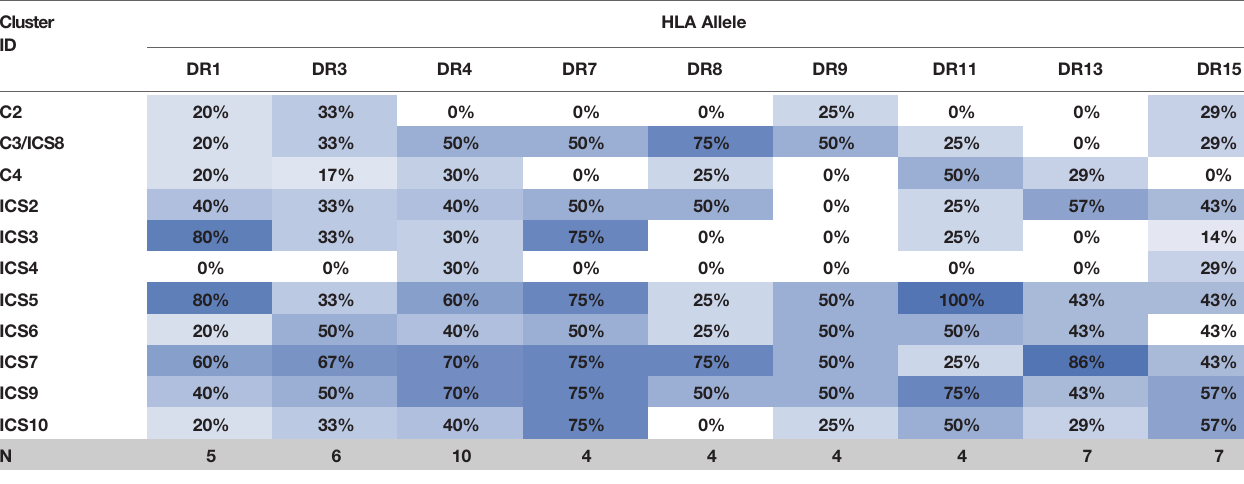
A Stimulation Index greater or equal to 1.5-fold above baseline is used to specify a positive donor response. The percentage of responding donors, by HLA allele for each predicted 3D7 and ICS cluster, is shown numerically along with color-coding to indicate higher percentages of responders with darker blues. The number of HLA-matched donors (N) for each allele is shown in the bottom row. A total of 30 donors were included in this study.